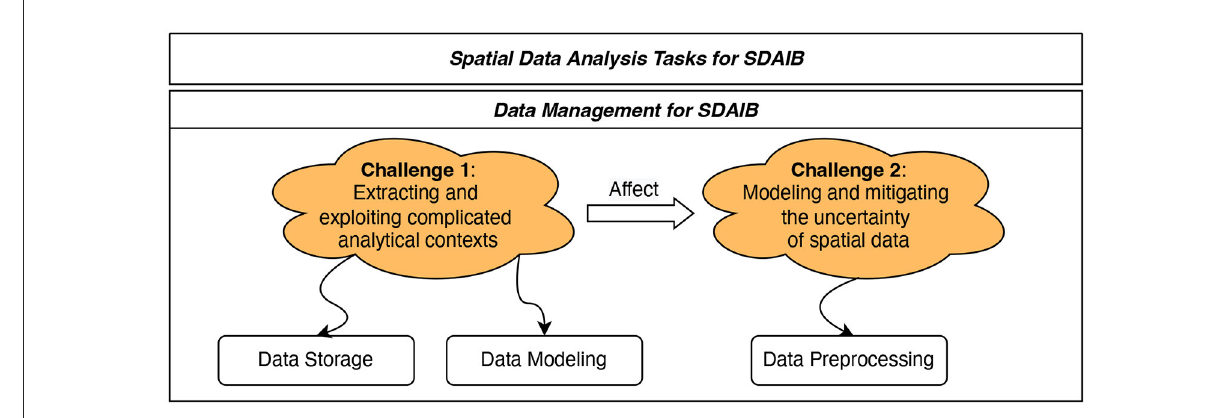
FIGURE2 Two general data management challenges in